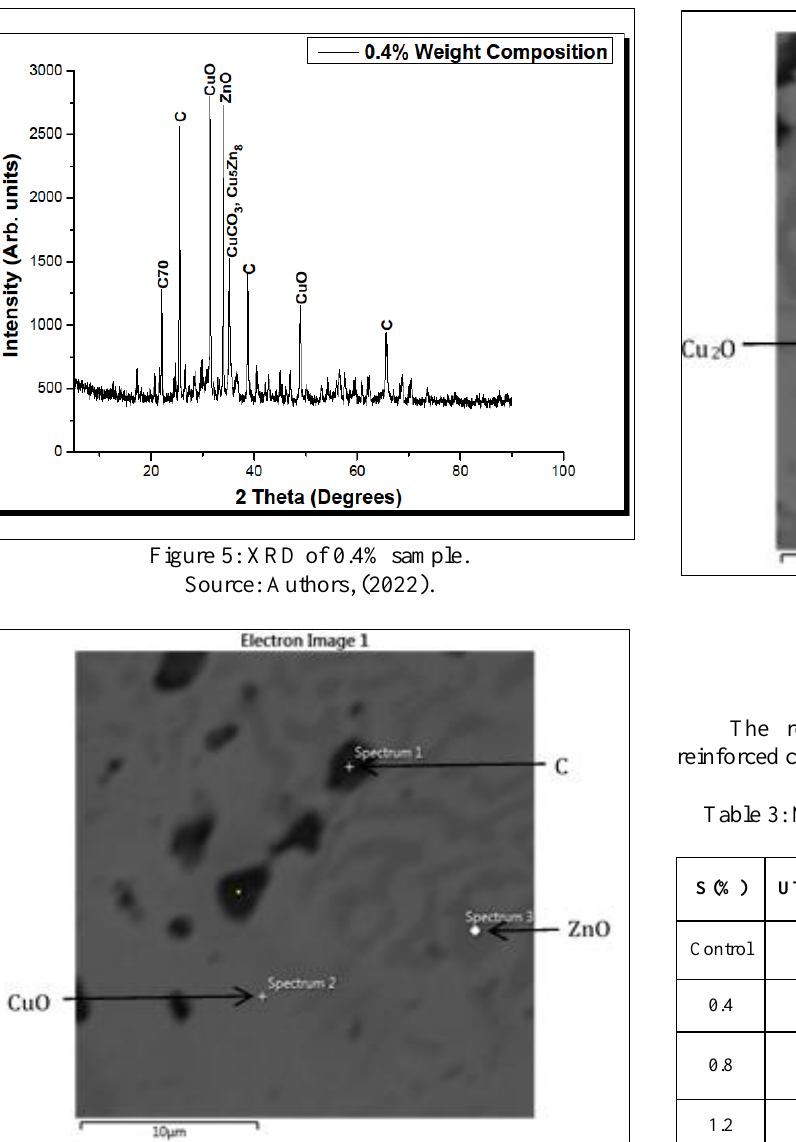
Figure 6: SEM Micrograph of 0.4% sample. Source: Authors, (2022).